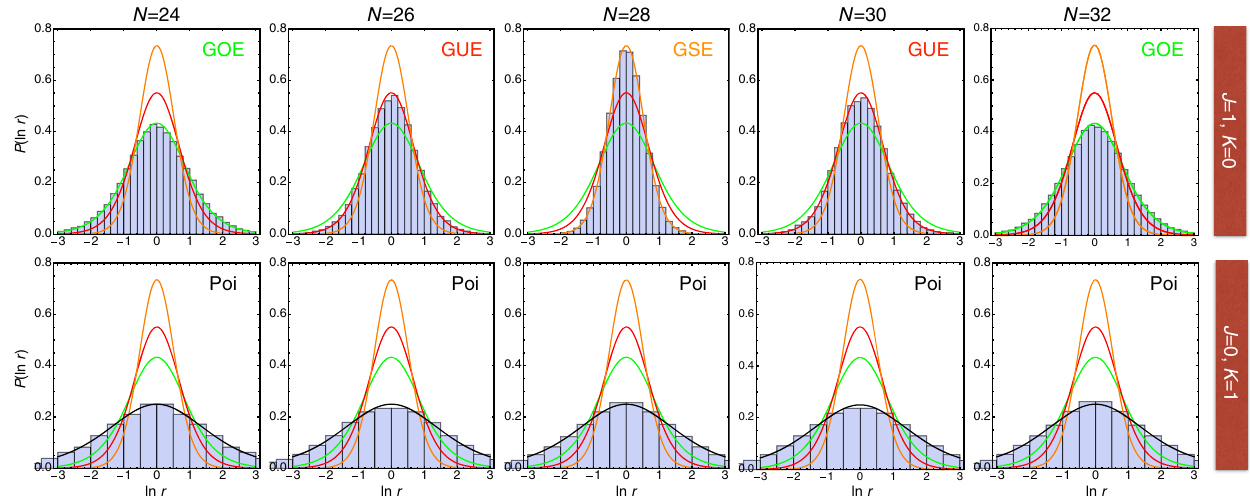
FIG. 6. Level statistics analysis. Top row: Histograms of ln r obtained from the energy levels of the SYK Hamiltonian Eq. (2.15) with n coupling constants taken from the giant vortex model with V 0 and w μ adjusted so that J ¼ 1 and K ¼ 0 . Solid lines indicate the expected distributions GOE (green), GUE (red), and GSE (orange) specified in Eq. (5.5). Bottom row: Results for the noninteracting case J ¼ 0 , K ¼ 1 . Black solid line represents the Poisson distribution Eq. (5.6). Histograms in all panels are averaged over eight independent realizations of disorder except for N ¼ 24 , where 16 realizations are employed to obtain satisfactory statistics, and N ¼ 32 , for which a single realization is